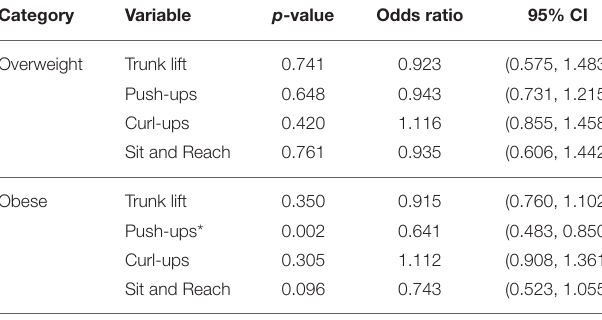
TABLE 3B | Associations between musculoskeletal fitness and weight status in first grade (reference group: obese). Category Overweight